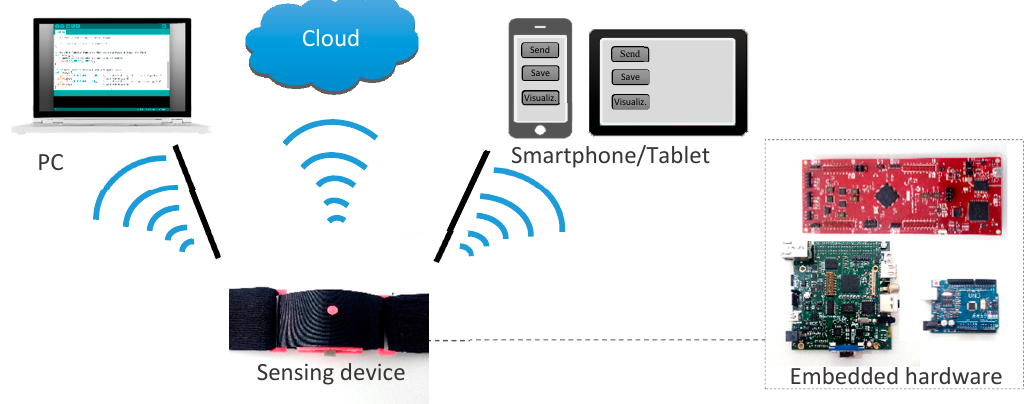
Cloud Cloud Cloud Cloud